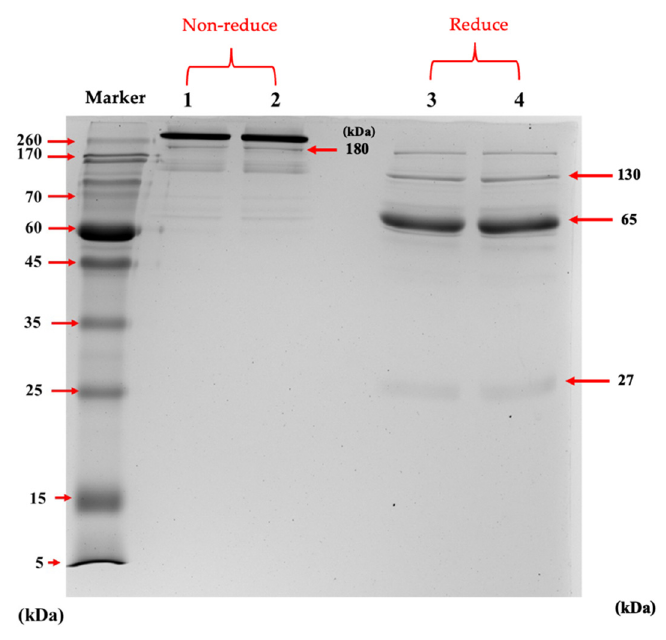
Figure 3. SDS–PAGE visualized intact IgY released from the antibody extracted from egg yolk. The HC heavy chain with 27, 65, and 130 kDa under reducing conditions and 130 kDa under non-reducing conditions appeared on the SDS–PAGE using 10% resolving SDS–PAGE gel.